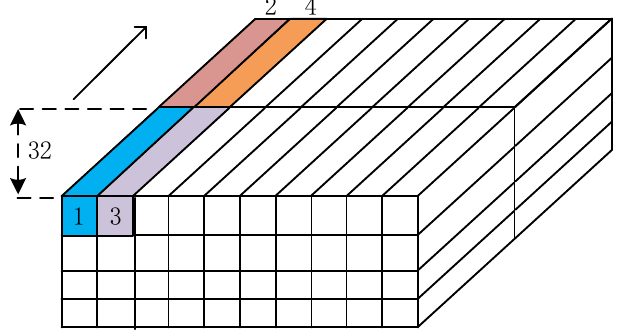
Figure 6. Input feature map data partitioning.